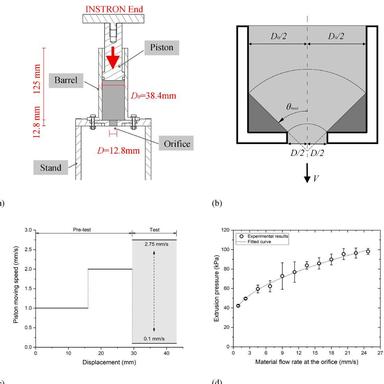
(a) Scheme of the ram extrusion setup; (b) Illustration of the orifice entrance flow region based on a spherical coordinate system; (c) A predefined ram extrusion test protocol; (d) An example of test results and the fitted curve (Basterfield et al. model). Adapted from Ref..